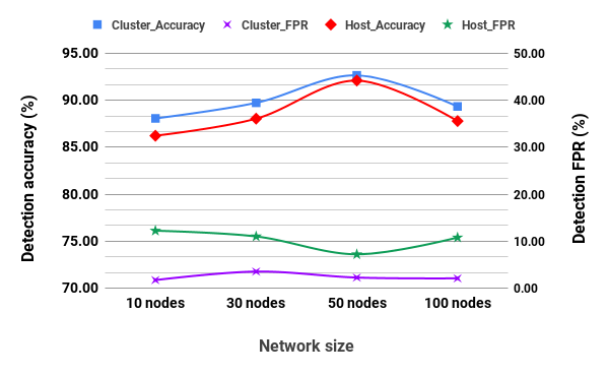
Figure 5. DT Exploratory network detection (Max speed of 4.3 m/s).